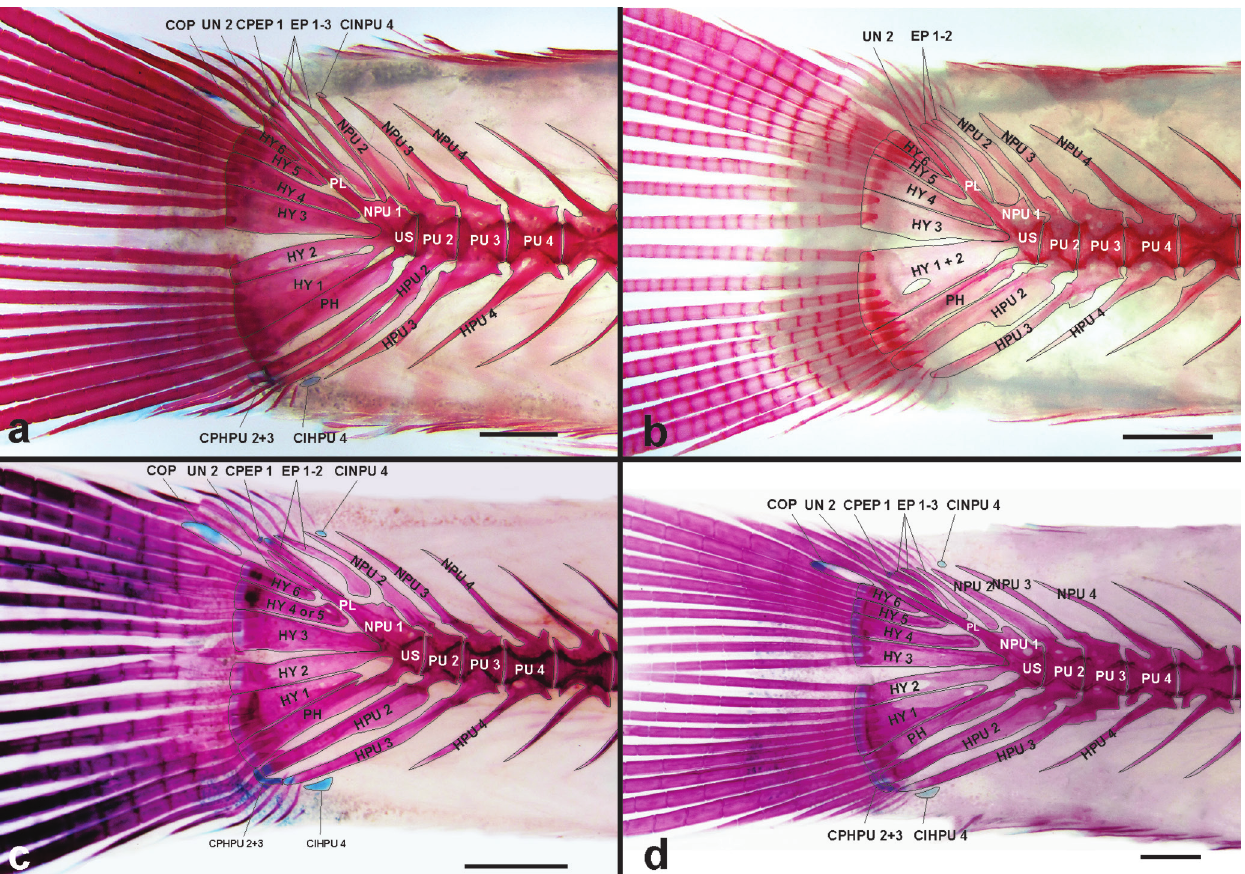
Fig. 3. Caudal-fin bony elements in Characidium travassosi (a = MZUSP 88142, 45.0 mm SL; b = MZUSP 68142, 45.6 mm SL; c = MZUSP 85938, 29.8 mm SL), and Characidium fasciatum (d = MZUSP 85995, 27.9 mm SL). Scale bar equals 1 mm. Specimens illustrated in a, c and d were double stained for bone and cartilage; specimen b was only stained for bone. The epineurals and epipleurals were removed during dissection; numbering of hypurals does not necessarily imply homology. Abbreviations are as follows: EP, epurals; HPU, haemal spine of pleural centrum; NPU, neural spine of pleural centrum; HY, hypural; NA, neural arch; NU, neural spine of ural centrum; PH, parahypural; PL, pleurostyle; PU, pleural centrum; US, urostyle; CIHPU, inter-neural spine of cartilage of pleural centrum; CPHPU, post-neural spine cartilage of pleural centrum; COP, opisthural cartilage; CPEP, post-epural cartilage; CINPU, inter- neural spine cartilage of pleural